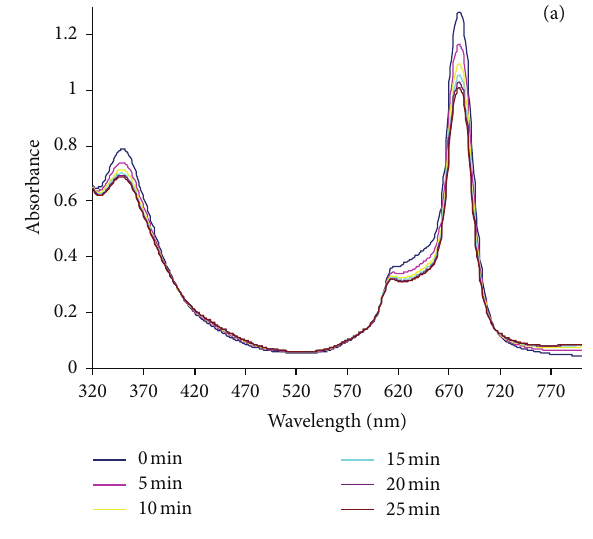
Figure 5: The photodegradation of compound 1d (a) in DMF showing the disappearance of the Q band at 5 min intervals.